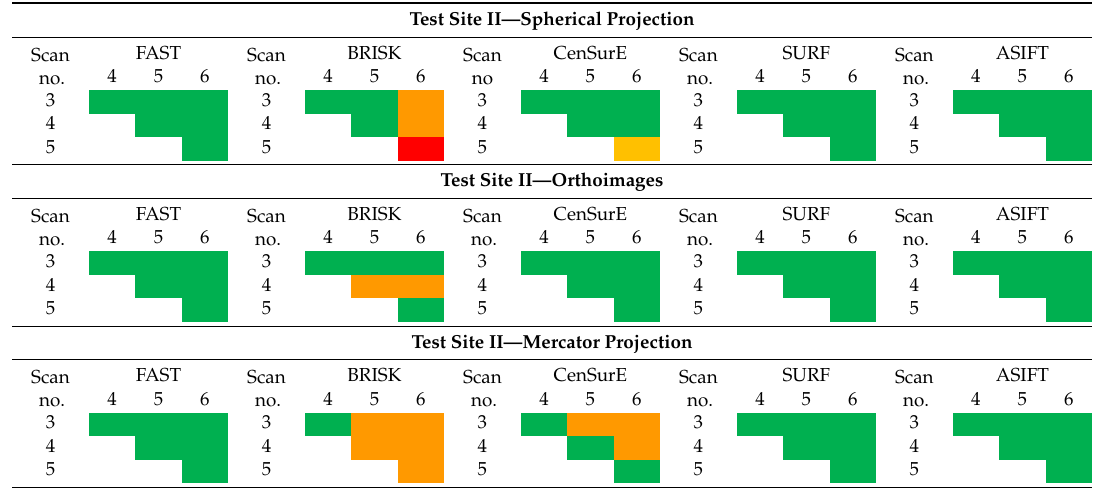
Table 3. The accuracy of the automated registration of scans for Test Site II (both scenarios): green, correct matching (full registration); orange, preliminary orientation requiring final registration using the ICP method; and red, no matching. “x” indicates no connection between scans (no overlap).